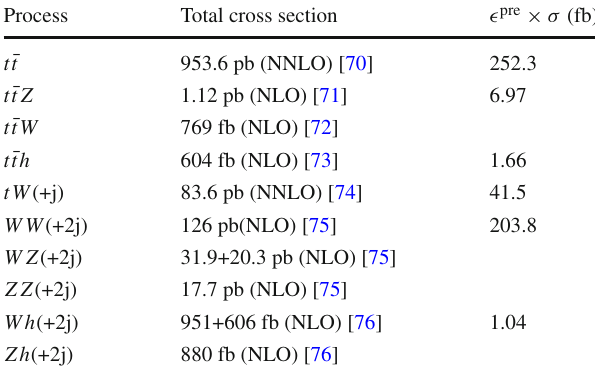
Table 3 Cross sections of backgrounds before and after preselections at 14 TeV LHC